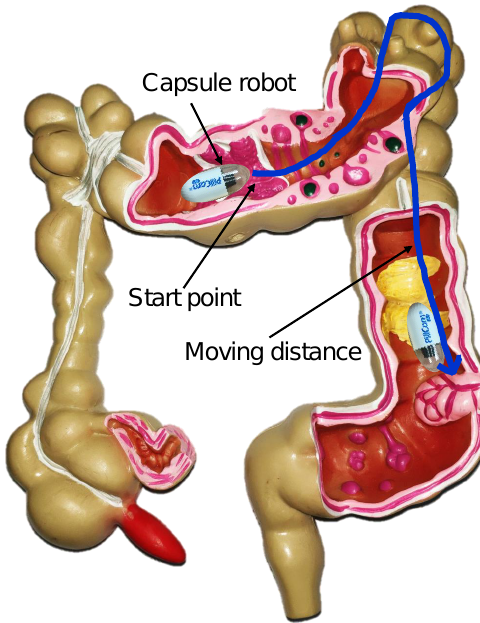
Figure 1. The proposed distance-based relative tracking method. The moving distance of the capsule robot relative to a marker position along the gastrointestinal (GI) tract was used to indicate the current position